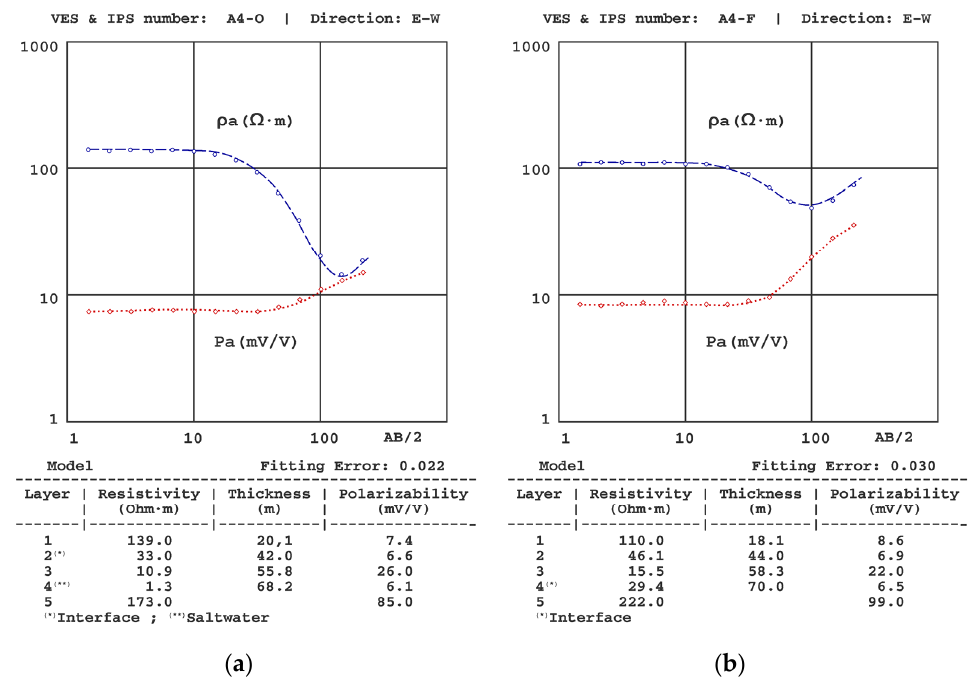
Figure 8. Results of the ( a ) A4-O VES-IPS obtained before winter and ( b ) A4-F VES-IPS obtained after winter.